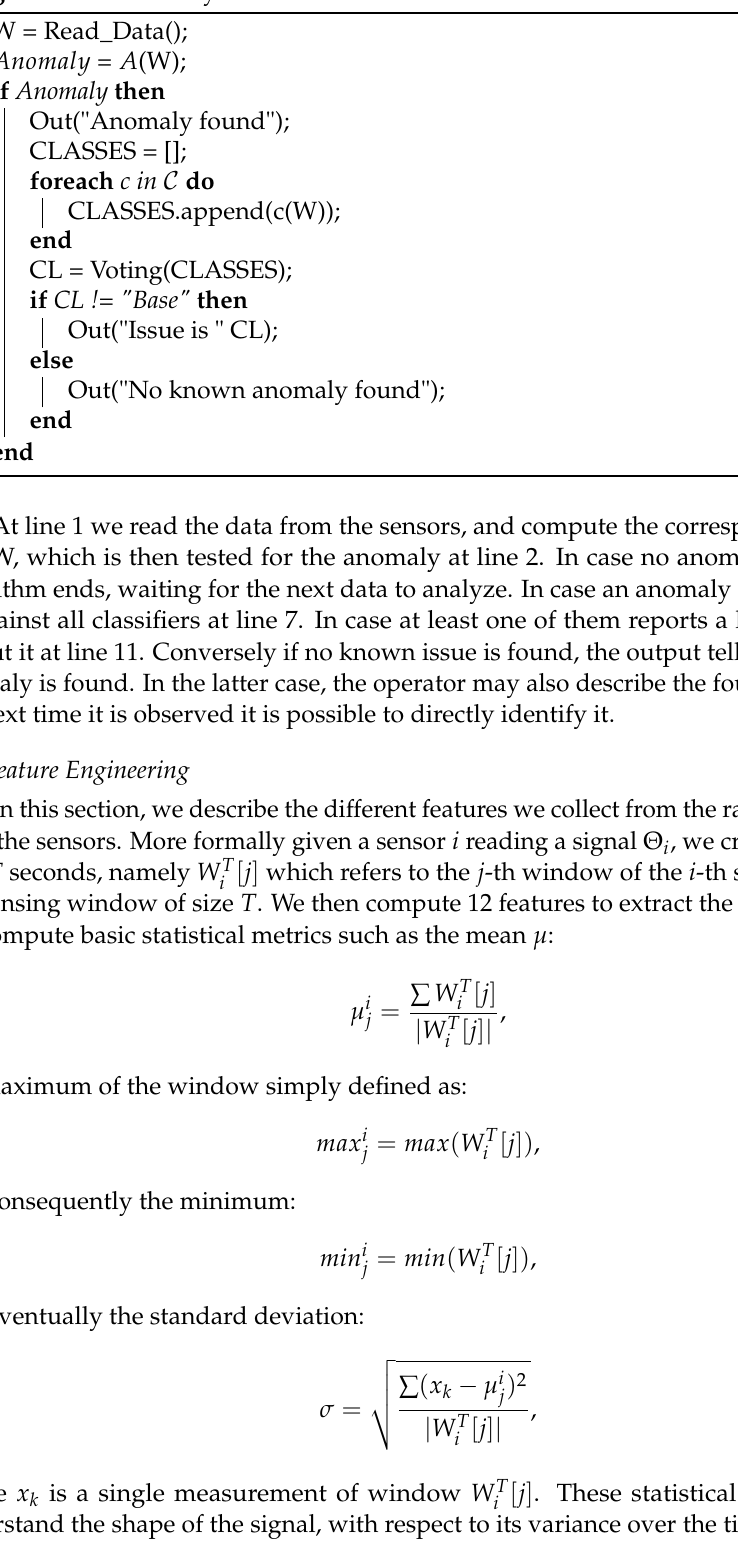
Algorithm 1: Anomaly detection and